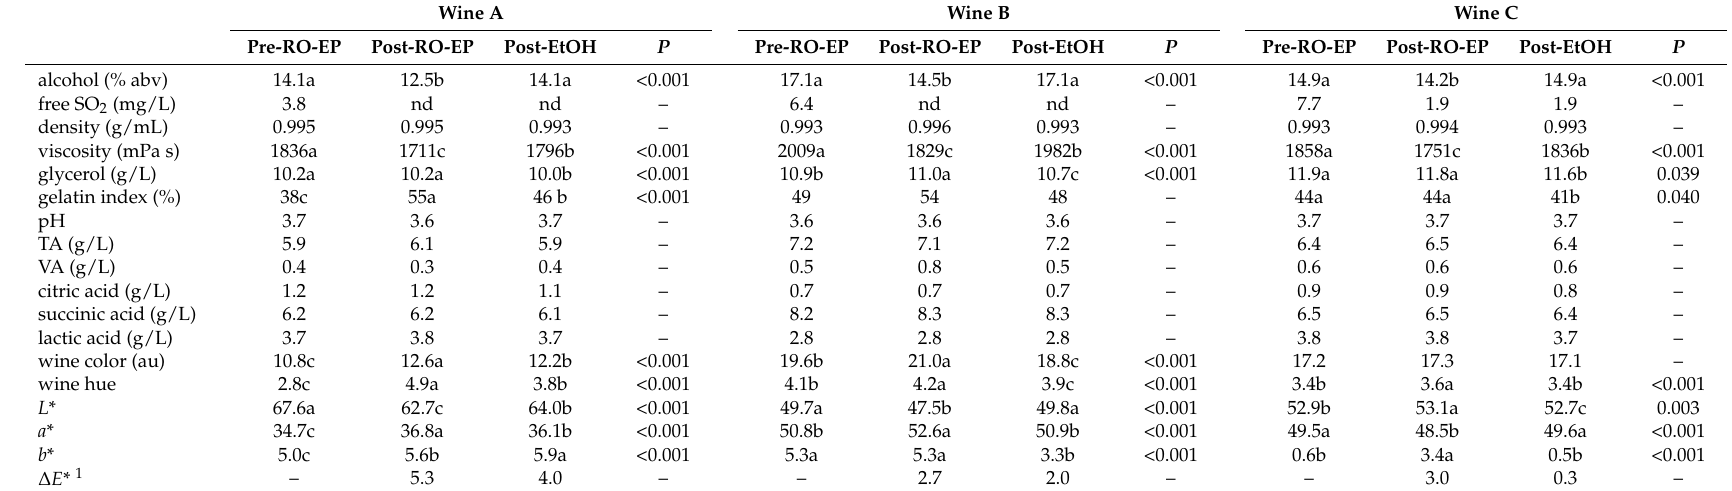
Table 1. Density, viscosity and basic composition of Trial 1 wines before and after RO-EP treatment, and following RO-EP treatment and alcohol re-adjustment.